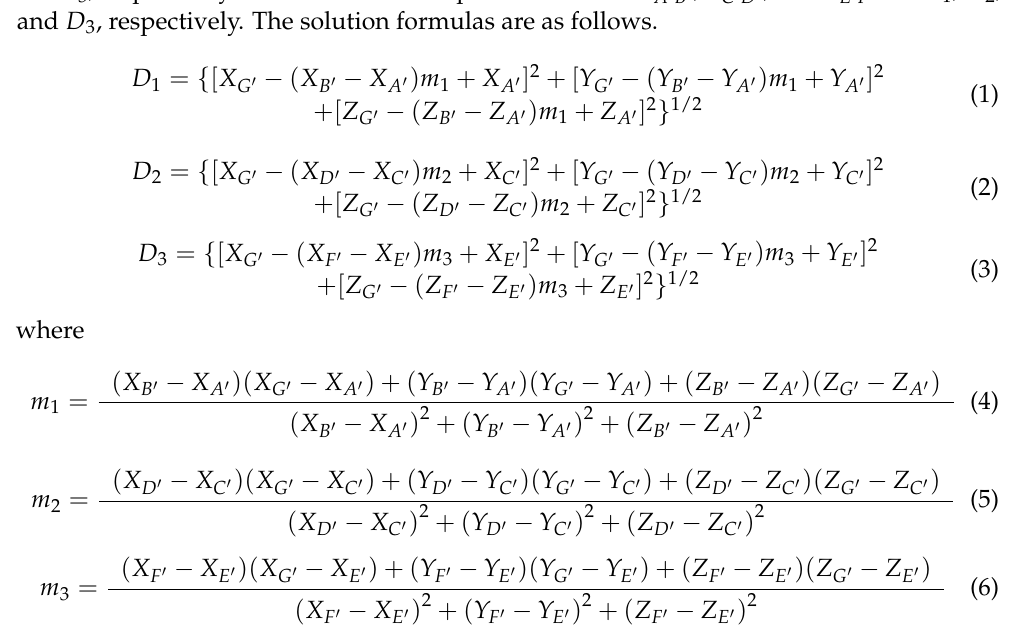
Figure 1. Schematic diagram of the intersection. The distances from image point g (cid:48) to image plane lines l a (cid:48) b (cid:48) , l c (cid:48) d (cid:48) , and l e (cid:48) f (cid:48) are d 1 , d 2